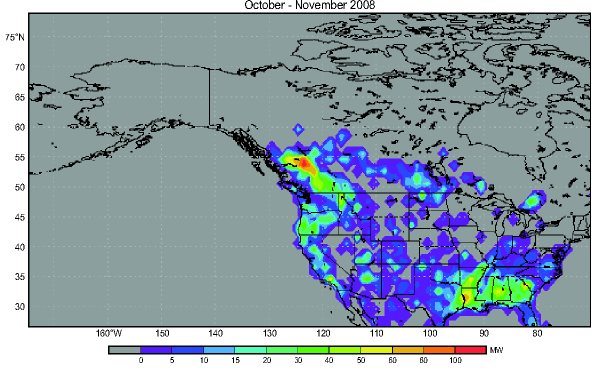
Fig. 14. Location of biomass fires in west-central North America based on the MODIS Fire Mapper (Giovanni program) for October- November of 2008. The Peace River agricultural area is situated at the maximum power location. The resolution of the fire radiative power field is 1 ◦ × 1 ◦